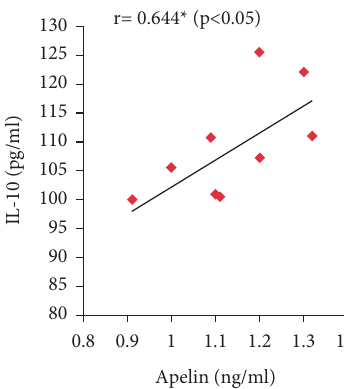
Figure 12: Correlation between serum apelin and IL-10 in the PE group.